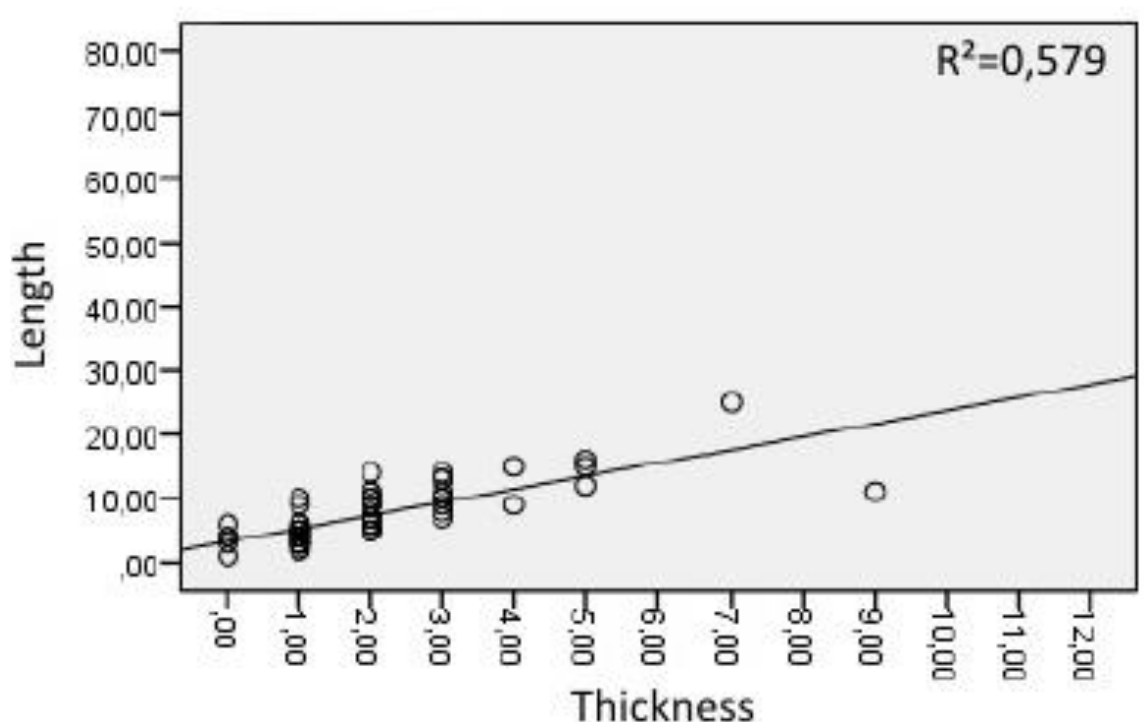
Figure 16. Coefficient of determination: R² Correlation of retouch flakes length and